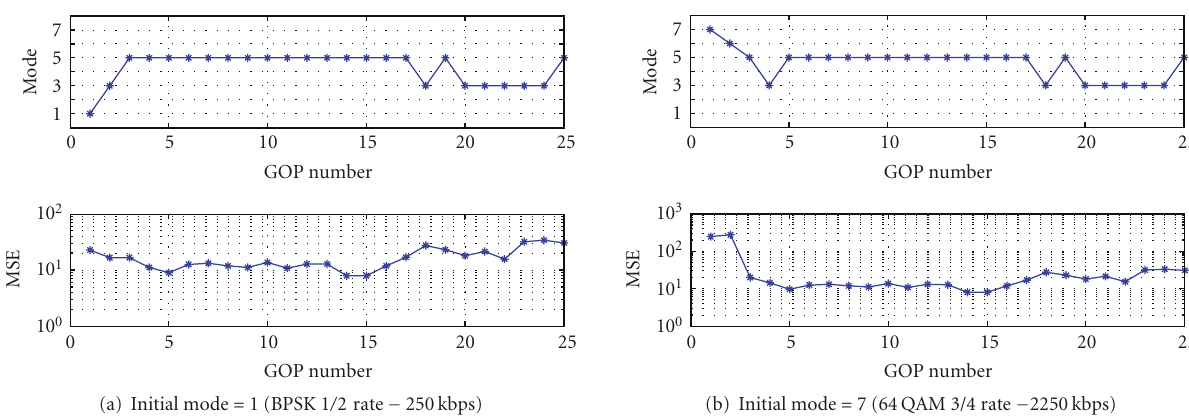
Figure 16: Mode and estimated distortion for foreman encoded with C/N = 20 dB, Set